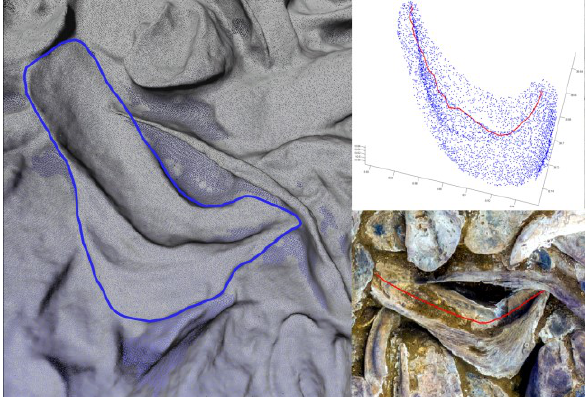
Figure 8: Curved shell mesh model (left); 3D central line and orthophoto (right)